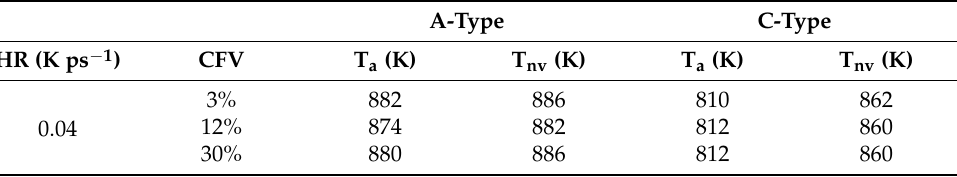
Figure 6. Example cross-sectional view of atomic configurations of the A-type stacked-NPs model with 30% core volume fraction in different instants (temperatures): ( a ) at 298 K, ( b ) at T a , ( c ) at T nv , and ( d ) at a relatively high temperature of 1050 K; panel ( d ) reveals the state of Ti cores in a large liquid oval with a melted Al shell in 3D view. Table 1. Aggregation temperature (T a ) and “no-void” temperature (T nv ) for both types with 3%, 12%, and 30% core volume fraction (CVF) NPs under 0.04, 0.2, 0.5, and 1.0 K ps − 1 heating rate (HR) melting